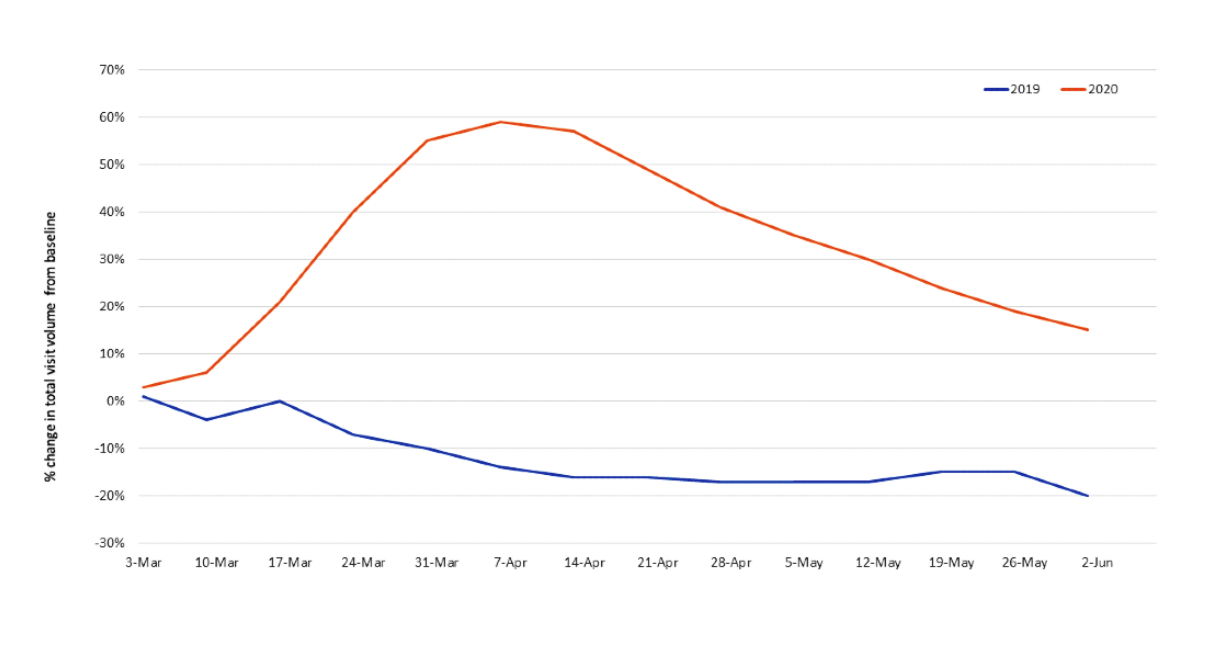
Figure 1. Percentage change in the total volume of virtual visits from the baseline week in 2019 and 2020. Baseline weeks: February 25 to March 3,